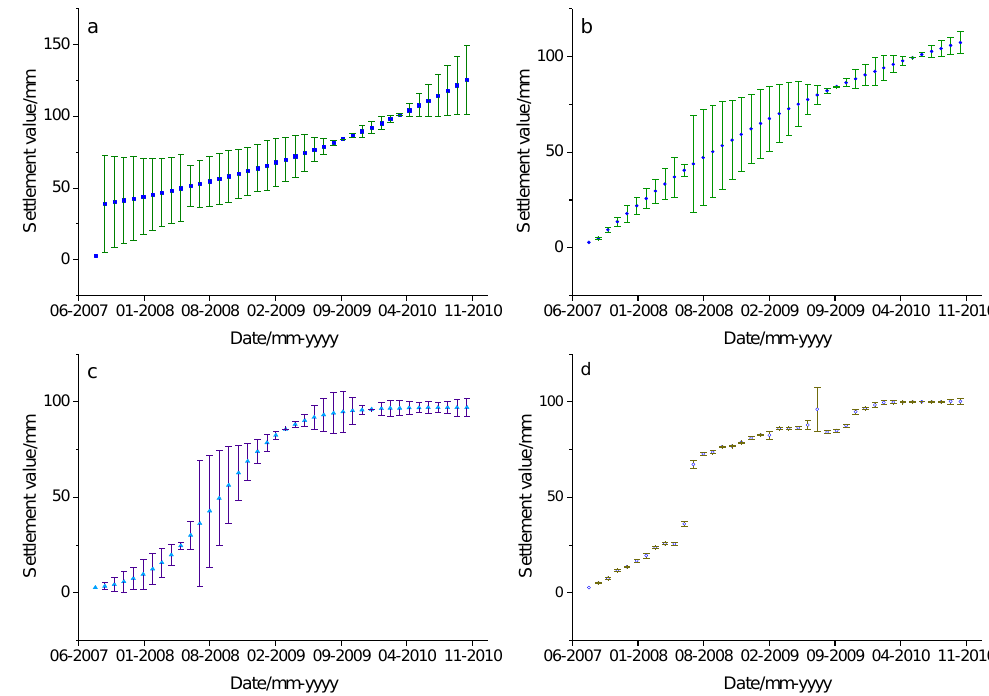
Figure 7. Simulated value error bar of four models to actual value from Aug-2007 to Nov-2010. ( a ) the traditional GM (1,1) model, ( b ) the GM (2,1) model, ( c ) the traditional Verhulst model, ( d ) the optimized Verhulst